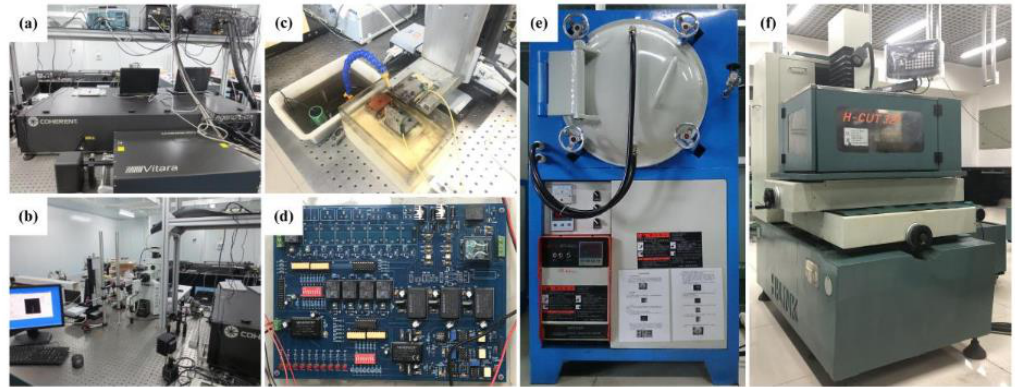
Figure 2. Pictures of experimental setup: ( a , b ) Femtosecond laser cutting system; ( c ) Micro-EDM platform; ( d ) Pulse power supply; ( e ) Vacuum furnace; ( f ) Wire EDM machine.